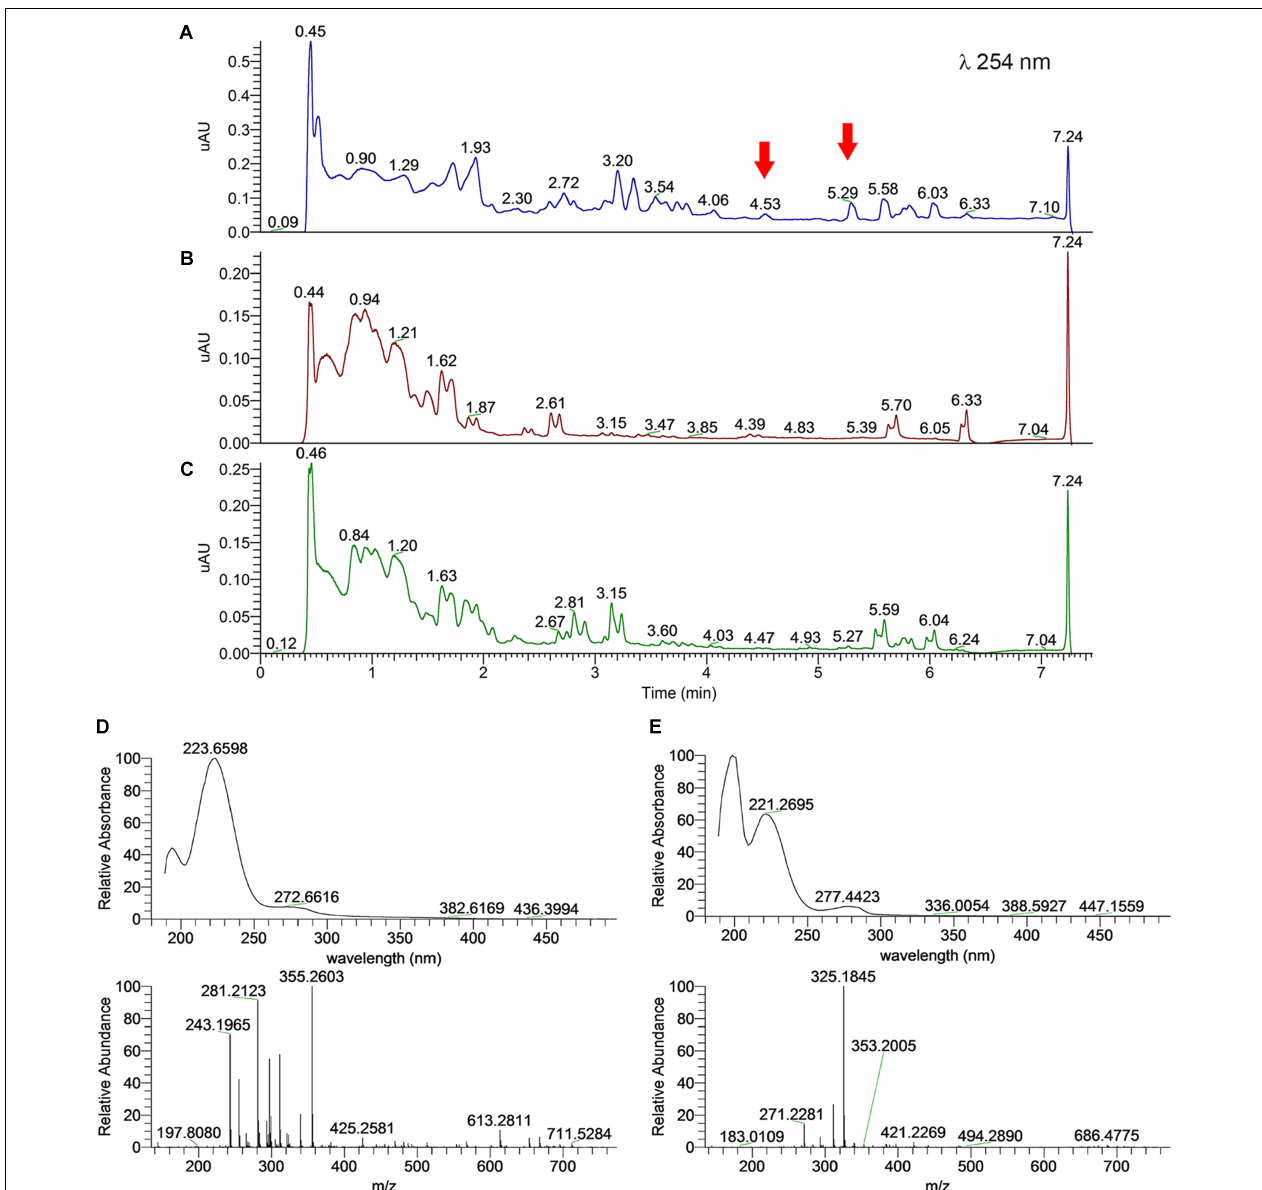
FIGURE 5 | Metabolome UPLC-MS profiles of the EtOAc extracts for potentially synergistic microbes, showing a differential production of metabolites on co-culture in relation to monocultures (arrows). (A) Co-culture of Coprinellus micaceus 2 and Aeromonas sp. 1; (B) Coprinellus micaceus 2 monoculture; and (C) Aeromonas sp. 1 monoculture. UV (top) and HRMS (bottom) spectra of compounds at (D) t R 4.53 ( m/z 355.2603 [M – H] − calc for 355.2602 C 19 H 35 N 2 O 4 , (cid:49) m i = +0.2 ppm) and (E) 5.29 ( m/z 325.1845 [M – H] − calc for 325.1841 C 10 H 25 N 6 O 6 , (cid:49) m i = +1.2 ppm) minutes in the